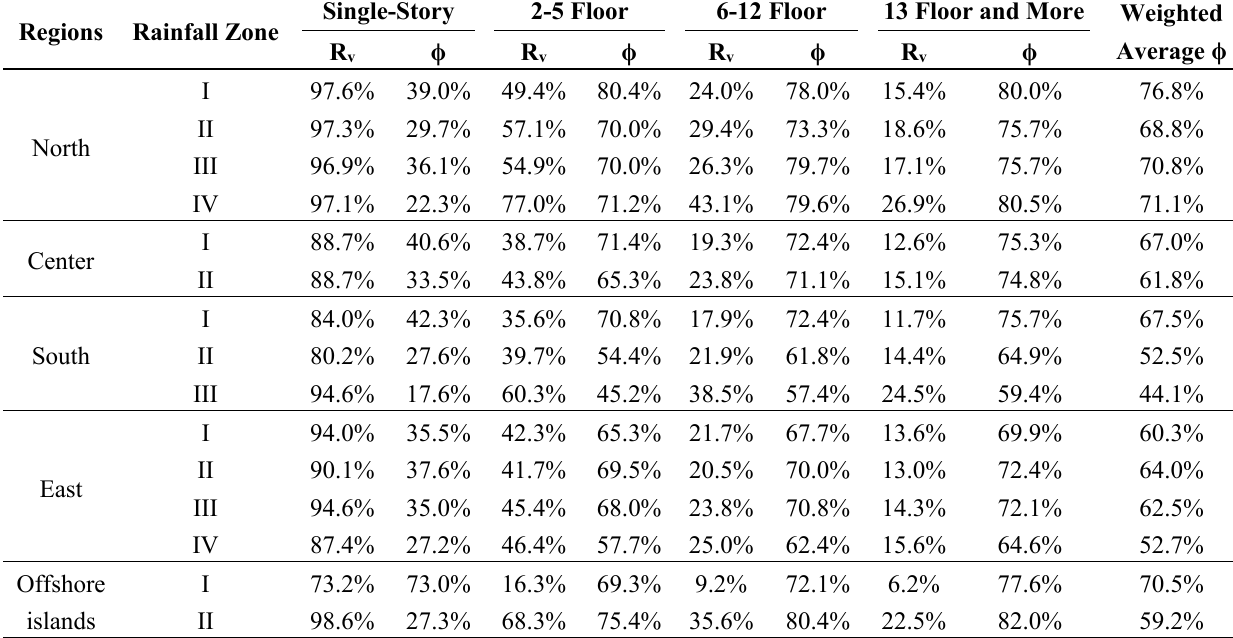
Table 6. Average values of optimal R v and percentages of rainwater used ( ϕ ) for different building types in different rainfall